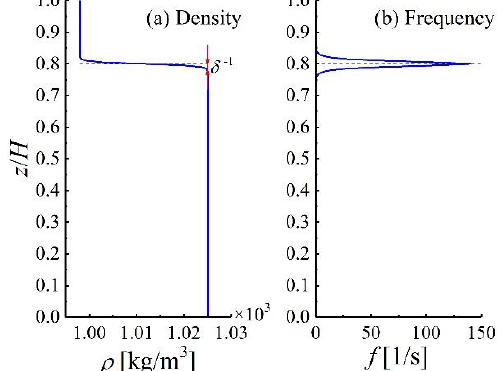
Figure 1. Density and Brunt-Bäisälä frequency distribution, the fluid depth ratio is h 1 : h 2 = 20:80. z is the vertical coordinate, H is the total fluid depth, ρ is the density.